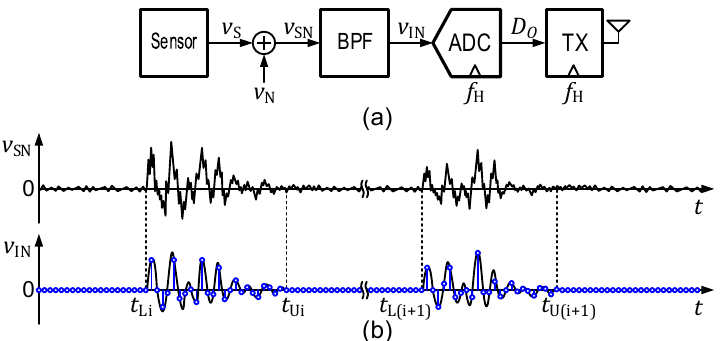
Figure 3. Conventional high-speed monitoring system with a band-pass filter (BPF) as a signal conditioner. ( a ) Block and ( b ) timing diagrams with noise.